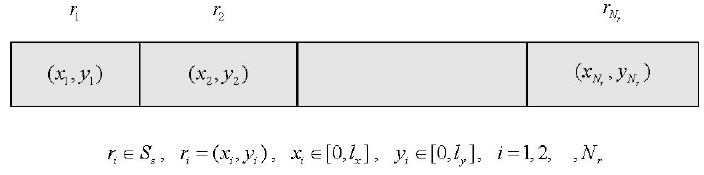
Figure 4. Individual